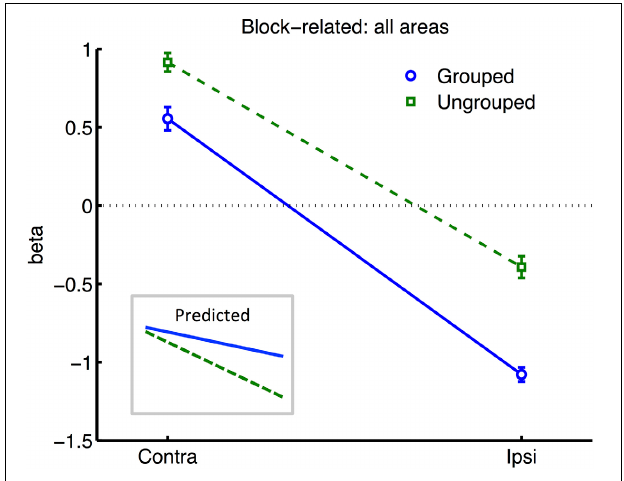
FIGURE 4 | Results from retinotopic analysis of Block-related BOLD, averaged across all visual areas. Normalized (see Methods) beta weights are plotted for hemispheres contralateral vs. ipsilateral to the cued visual hemifield, for grouped (blue circles and solid lines) vs. ungrouped stimuli (green squares and dashed lines). In all graphs, error-bars indicate one unit of within-subjects standard error. Inset shows predictions assuming facilitatory and automatic spreading of object-based attention.